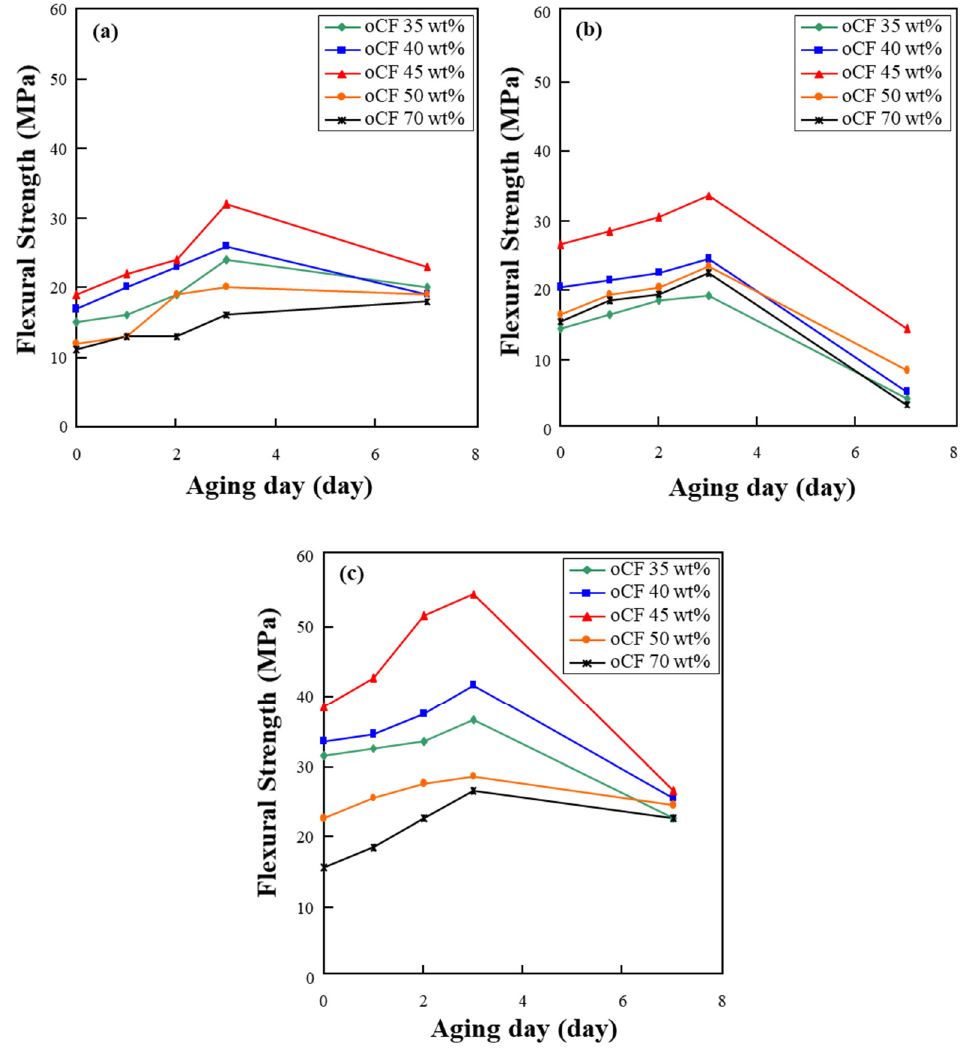
Figure 5. Variation in flexural strength of oCFOCs by aging days: ( a ) HDPE, ( b ) LDPE, and ( c ) PP.